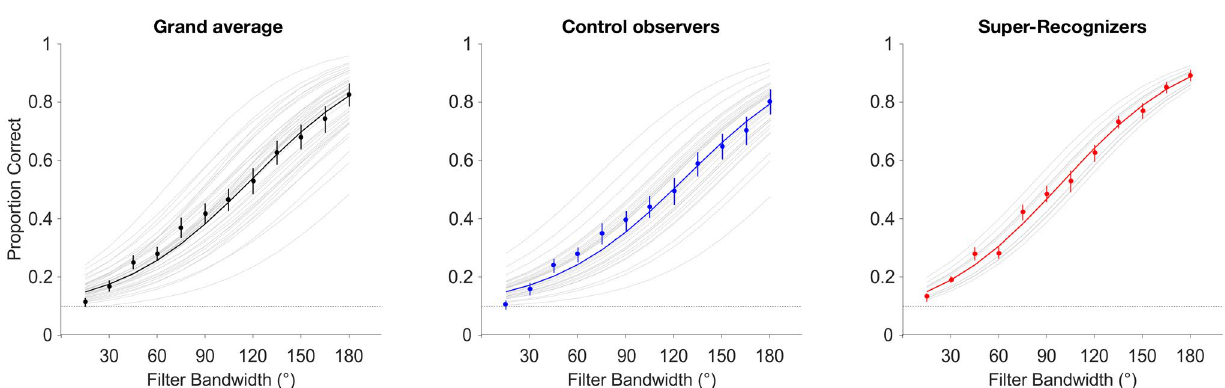
Figure 4. Logistic fits correct responding accounting for Group. Grand averaged data (left) from Model 3 are plotted alongside Model 5’s fits (with gray tracings displaying individual fits to observers’ data) to control observers (middle) and SRs (right) for comparison. Error bars represent ± 1SEM; dotted lines represent chance